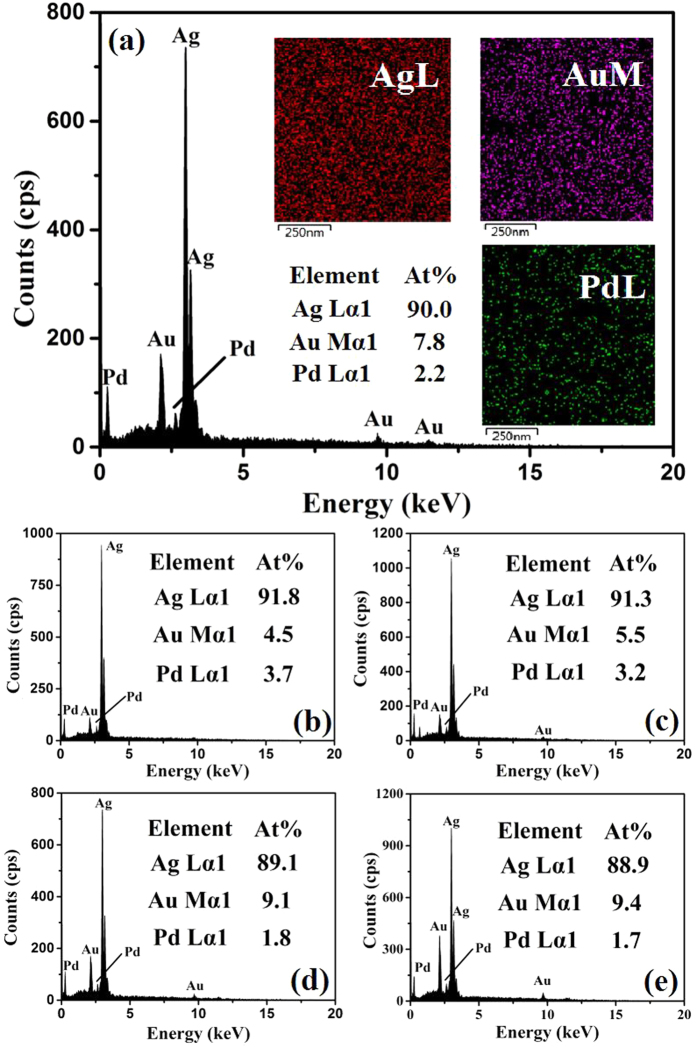
(a) EDX patterns of the typical Ag0.90Au0.08Pd0.02 networks, (b) Ag0.92Au0.04Pd0.04, (c) Ag0.91Au0.06Pd0.03, (d) Ag0.89Au0.09Pd0.02, and (e) Ag0.89Au0.095Pd0.015. Insets of (a) are X-ray elemental mappings of elemental Ag, Au, and Pd recorded from the typical Ag0.90Au0.08Pd0.02.